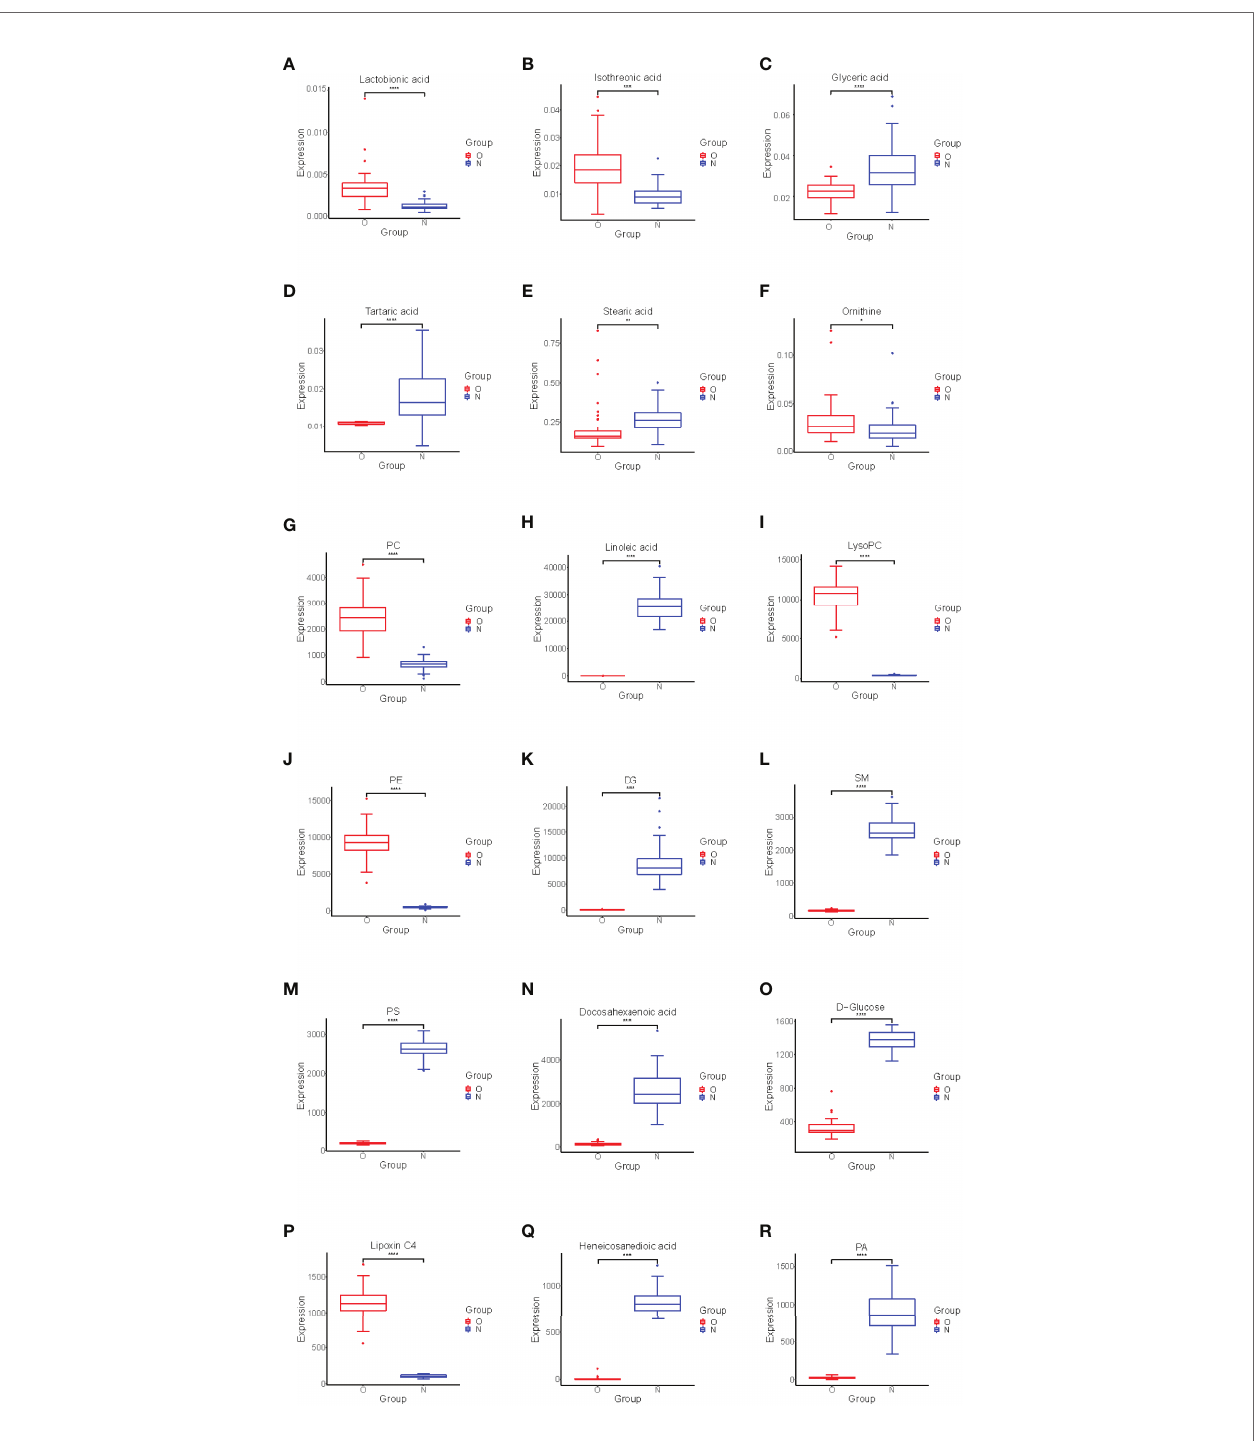
FIGURE 3 | Box-and-whisker plots showing the relative levels of selected potential biomarkers for the postmenopausal women with OP. (A – F) were found by GC- MS, (G – R) were found by LC-MS. The red box on the left represents the case group, and the blue box on the right represents the healthy control group. Horizontal line in the middle portion of the box, median; bottom and top boundaries of boxes, lower and upper quartiles; whiskers, 5th and 95th percentiles. *p < 0.05, **p < 0.01, ***p < 0.001, ****p < 0.0001. PC, Phosphatidylcholine; LysoPC, lysophosphatidylcholine; PE, phosphatidylethanolamine; DG, Diacylglycerol; PS, phosphatidylserine; SM, sphingomyelin; PA, phosphatidic